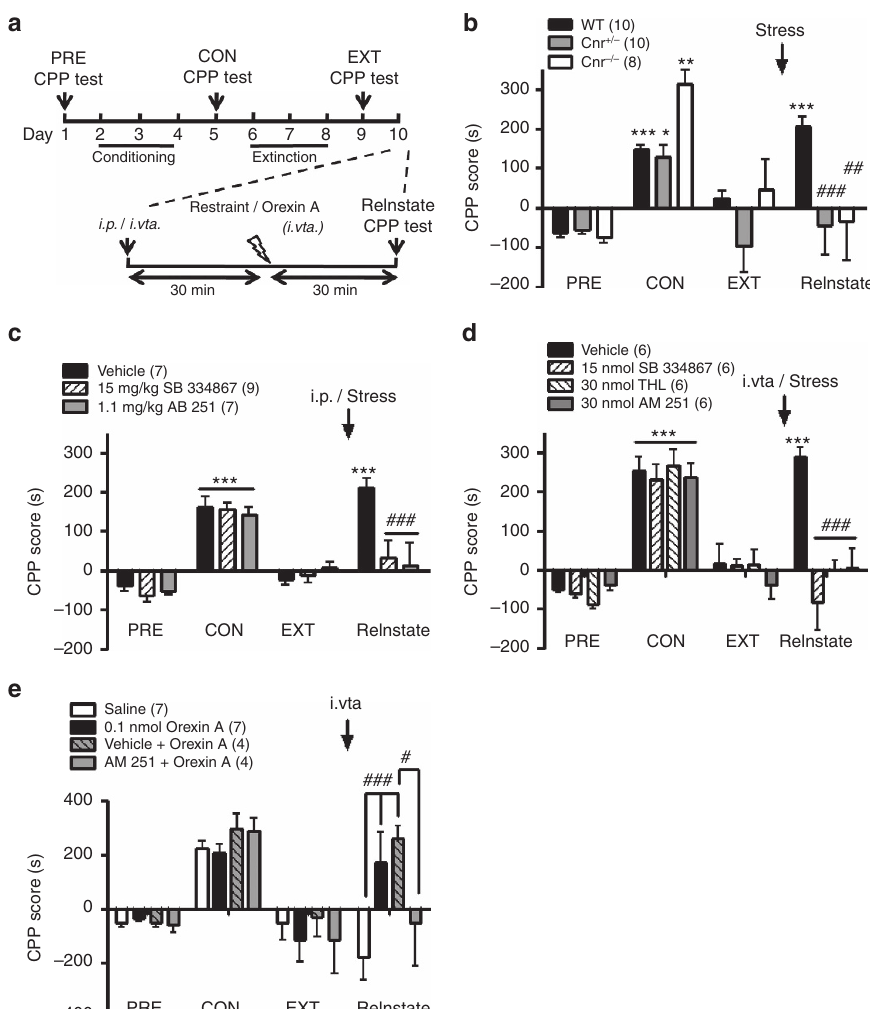
Figure 6 | Restraint stress or intra-VTA microinjection of orexin A reinstated extinguished cocaine-CPP in WT, but not in Cnr1 KO mice or in mice pretreated with an OX1R or CB1R antagonist. ( a ) The protocol for inducing, extinguishing, and reinstating cocaine-CPP. Four stages were analysed: preconditioning 1 , conditioning 35 , extinction and reinstatement. Mice received daily pairing of cocaine (i.p. 20mgkg (cid:2) 1 ) on days 2–4 to develop cocaine CPP, followed by a 3-day forced extinction training by daily paring of saline with the cocaine-paired chamber on days 6–8. ( b – e ) On day 10, ( b – d ) a 30-min restraint stress or ( e ) bilateral intra-VTA microinjection (i.vta.) of 0.1nmol orexin A for 30min was applied before the CPP test to reinstate extinguished cocaine CPP. The CPP test was conducted before (day 1, PRE) and after (day 5, CON) cocaine-conditioning, after extinction (day 9, extinction) and after restraint stress/i.vta. orexin A (day 10, reinstatement). Antagonists were given 30min before restraint stress by either i.p. injection or bilateral i.vta. microinjection. The degree of cocaine seeking was determined by the CPP score as described in Methods section. ( b – d ) CPP scores at various stages ( b ) in WT ( n ¼ 10, black bars), Cnr1 þ / (cid:2) ( n ¼ 10, grey bars) or Cnr1 (cid:2) / (cid:2) ( n ¼ 8, open bars) mice, or in mice ( c ) i.p. or ( d ) i.vta. pretreated with vehicle (i.p.: n ¼ 7, i.vta: n ¼ 6, black bars), SB-334867 (i.p.: n ¼ 9, i.vta: n ¼ 6, left slashed bars), AM 251 (i.p.: n ¼ 7, i.vta: n ¼ 6, grey bars) or THL ( n ¼ 6, right slashed bars) before receiving restraint stress. ( e ) CPP scores at various stages in mice, after extinction, i.vta. microinjection of orexin A ( n ¼ 7, black bars), saline ( n ¼ 7, open bars), orexin A þ AM 251 ( n ¼ 4, grey bars) or orexin A þ vehicle ( n ¼ 4, right slashed grey bars). * P o 0.05, ** P o 0.01, *** P o 0.01 versus the PRE stage ; # P o 0.05, ## P o 0.01, ### P o 0.001 versus ( b – d ) the WT, or the vehicle or ( e ) the saline group (two-way ANOVA with Bonferroni post hoc test). Data are expressed as mean ± Mice were randomly divided into four groups and killed at one of four stages of the cocaine CPP model. The percentage of c-fos-expressing orexin neurons in the LH of mice at the CON stage was significantly higher than at the PRE stage (Fig. 7c).